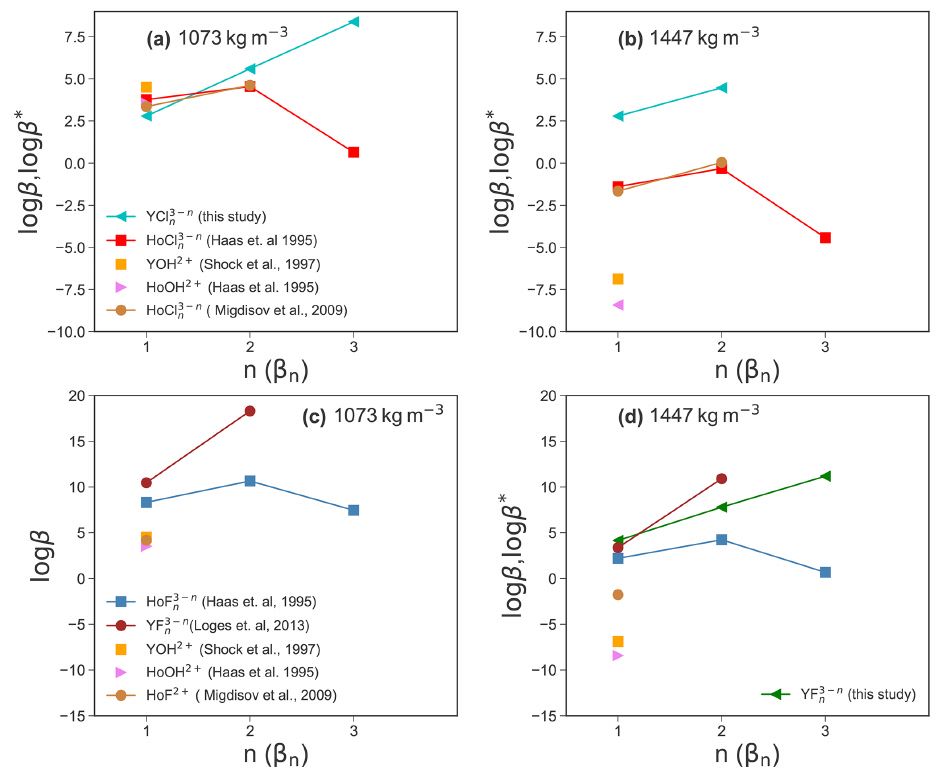
Figure 11. Comparison of the aqueous species stability derived from the AIMD simulation and HKF regression using the DEW model (Sverjensky et al., 2014) at 800 ◦ C and a fluid density of 1072 and 1447kgm − 3